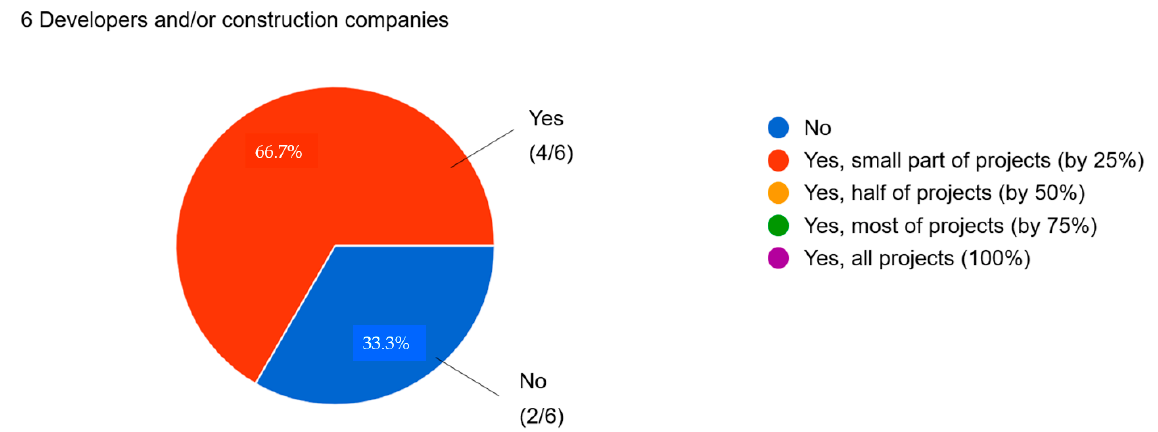
Figure 2. Design firms’ experiences with BIM.